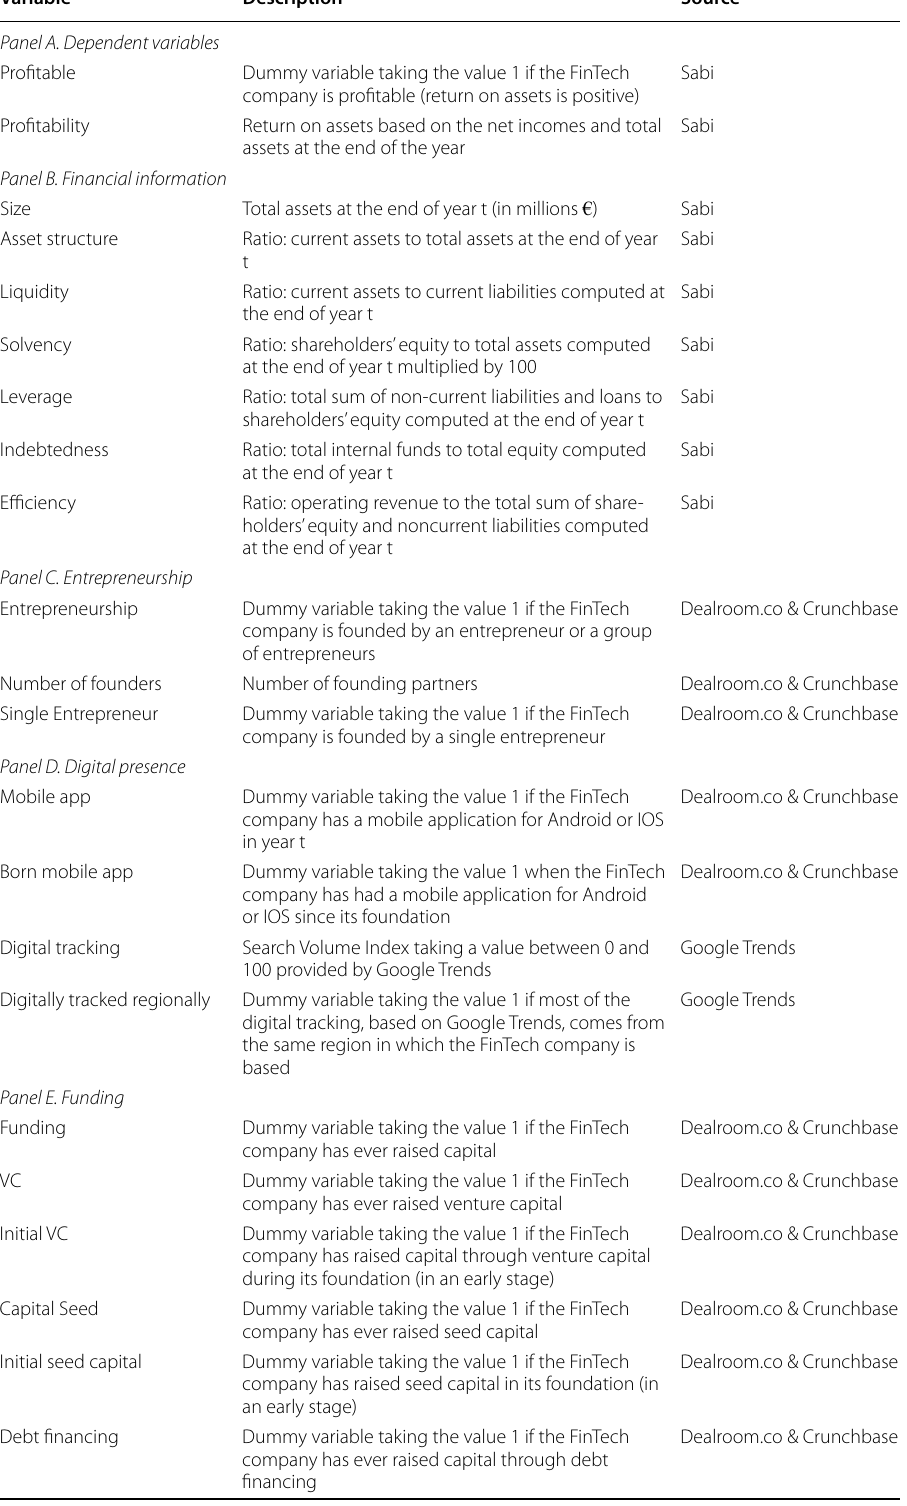
Table 2 Variables description and source Variable Description Source Panel A. Dependent